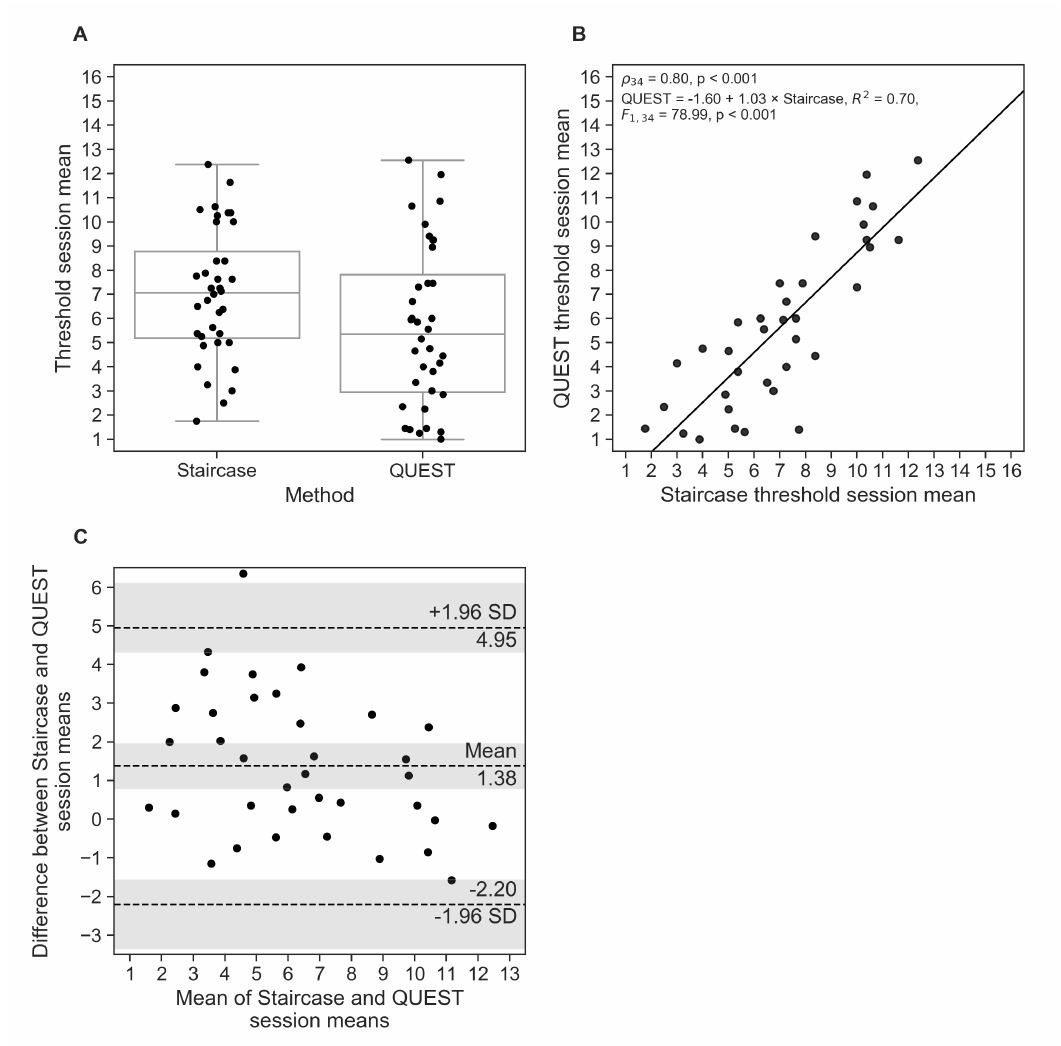
Figure 3. ( A ) Mean threshold estimates, averaged across Test and Retest sessions for the staircase and QUEST procedures. Horizontal lines show the median values, and whisker lengths represent 1.5 × inter-quartile range. ( B ) Correlation between mean staircase and QUEST threshold estimates. ( C ) Bland–Altman plot showing mean differences between session means in both procedures, and limits of agreement corresponding to 95% confidence intervals (CIs) as mean ± 1.96 × SD. The shaded areas represent the 95% CIs of the mean and the limits of agreement. Each dot represents one